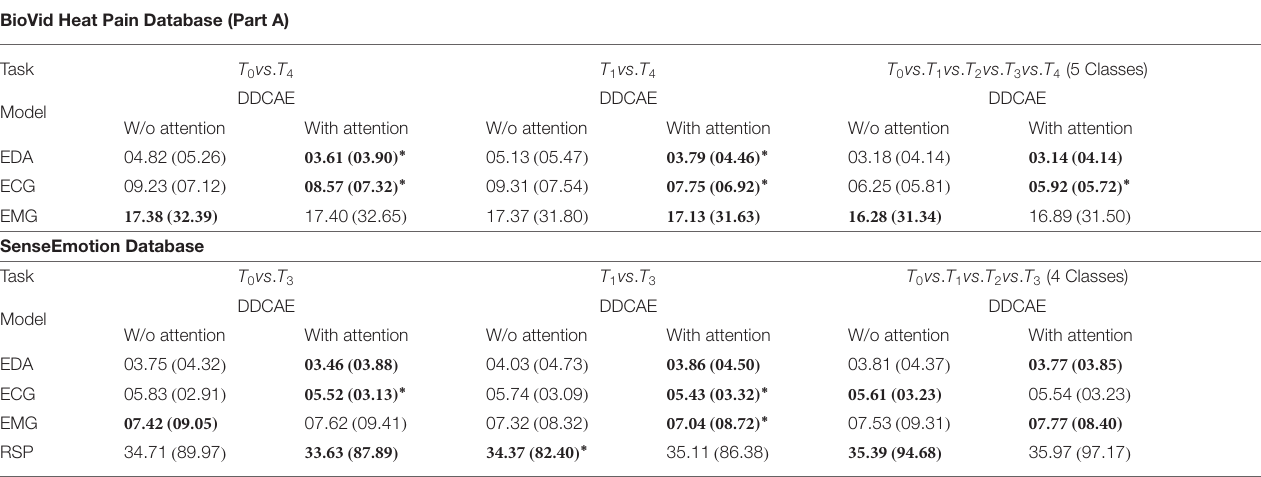
TABLE 3 | Signal reconstruction performance [Mean Squared Error (MSE)] comparison in a Leave One Subject Out (LOSO) cross-validation evaluation setting: Average MSE in % (standard deviation in % ). BioVid Heat Pain Database (Part A)